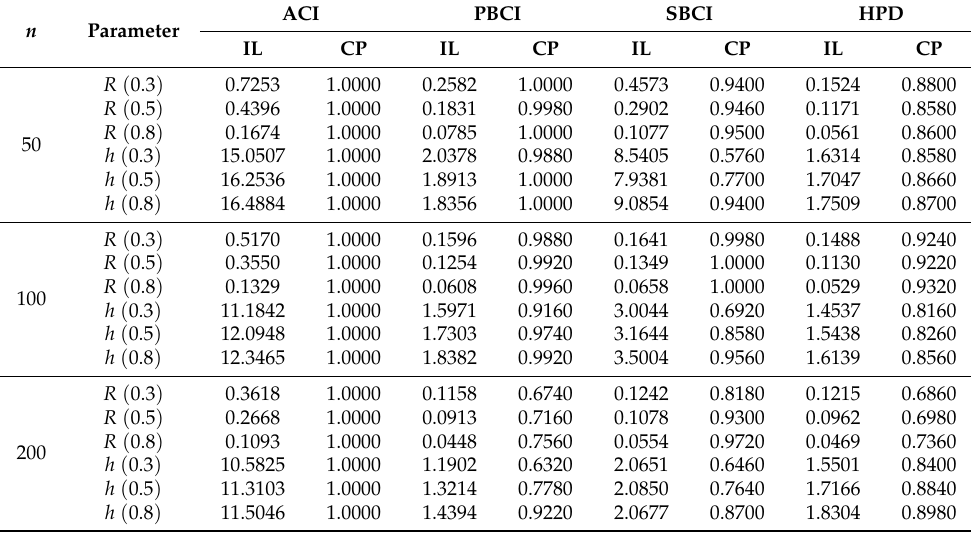
Table 12. Interval estimates of R ( x ) and h ( x ) at x = { 0.3,0.5,0.8 } under Scheme